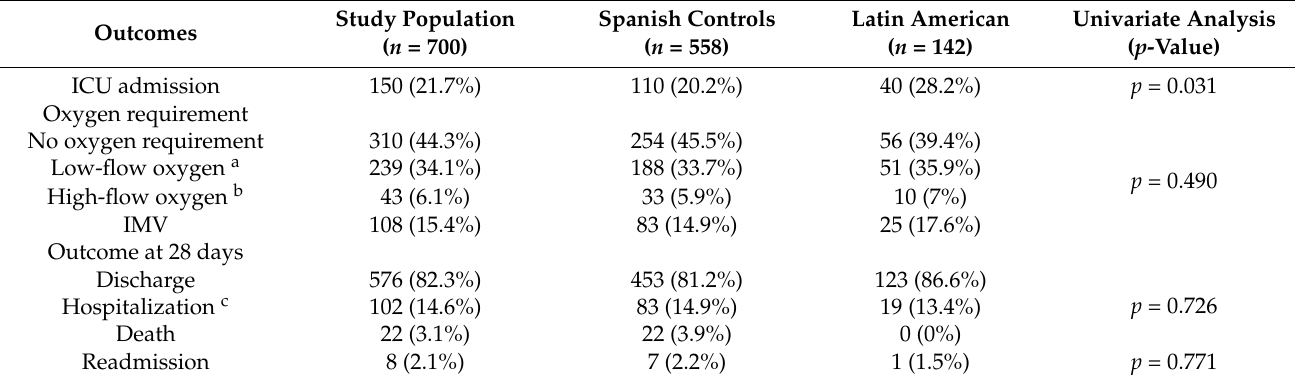
Table 4. Clinical outcomes in hospitalized patients with COVID-19 pneumonia according to the geographical area of origin.